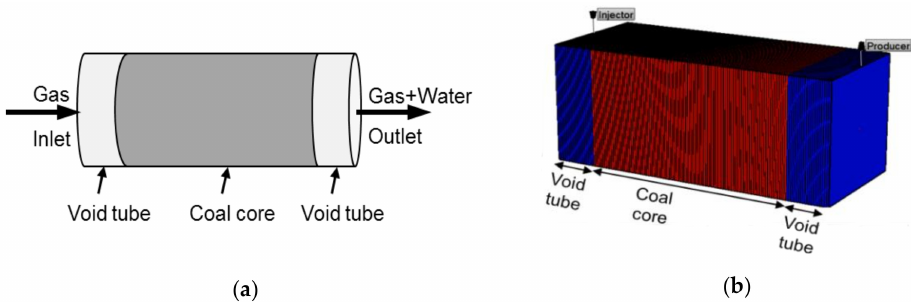
Figure 5. Illustration of the ( a ) real core flooding and ( b ) synthetic numerical core flooding tests.